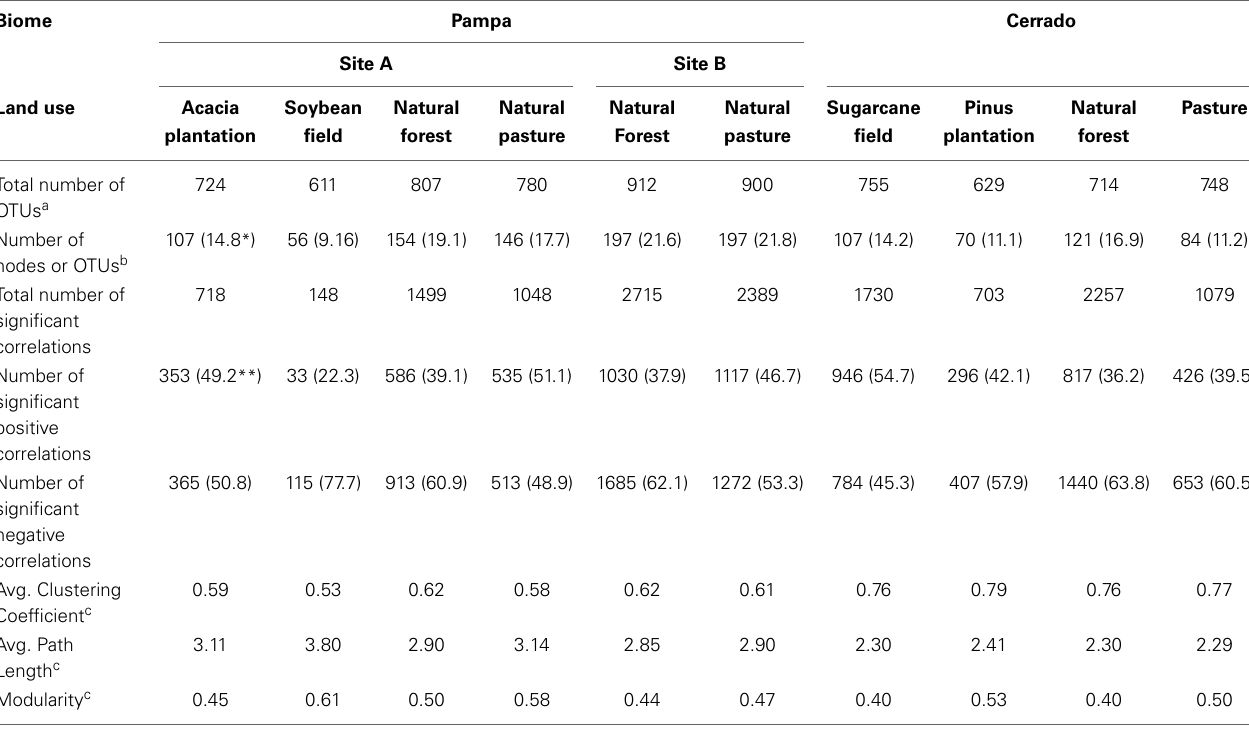
Table 2 | Global network statistics for microbial association networks from land uses in Pampa and Cerrado biome.